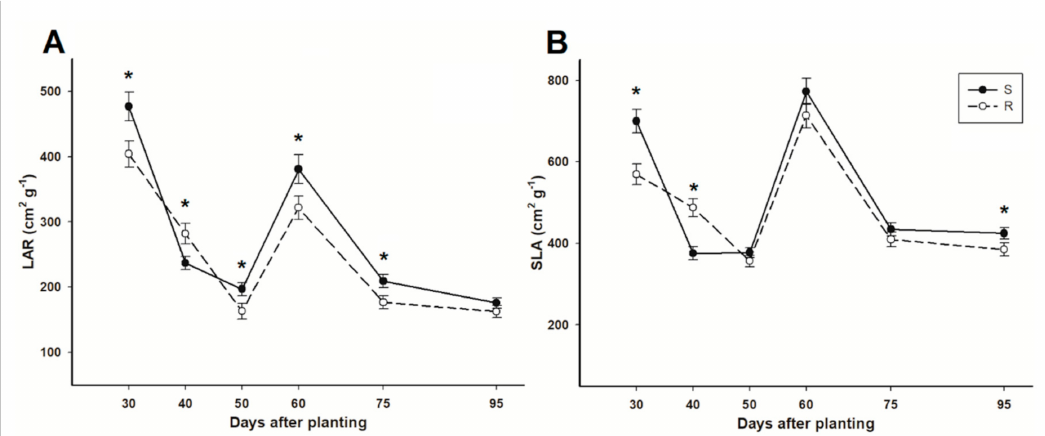
Figure 5. LAR—leaf area ratio ( A ) and SLA—specific leaf area ( B ) of imazamox-resistant (R) and susceptible (S) wild poinsettia plants. * indicates significant di ff erences at p < 0.05. Vertical bars ± standard error ( n =